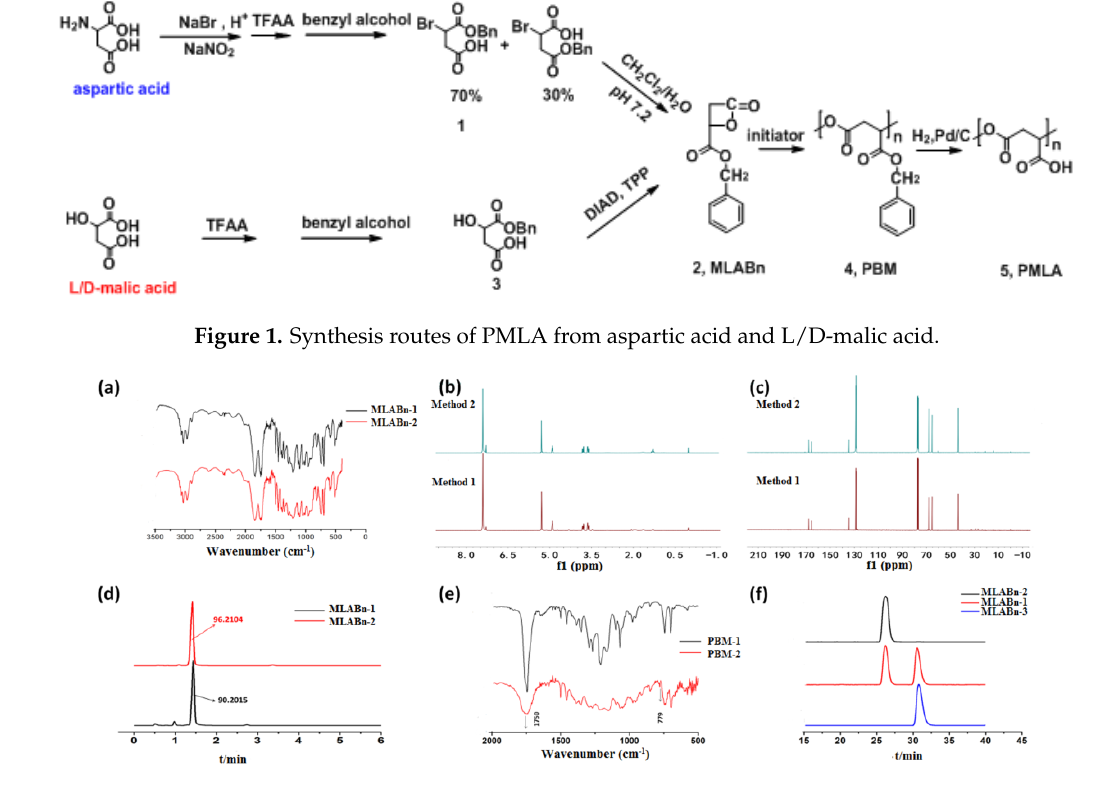
Figure 2. Structural characterization of products synthesized by aspartic acid or L / D -malic acid. ( a ) FTIR spectrum of MLABn; ( b ) 1 H NMR spectrum of MLABn; ( c ) 13 C NMR spectrum of MLABn; ( d ) HPLC of MLABn by C 18 column; ( e ) FTIR spectra of PBM; ( f ) HPLC of MLABn by chiral OD − H column.